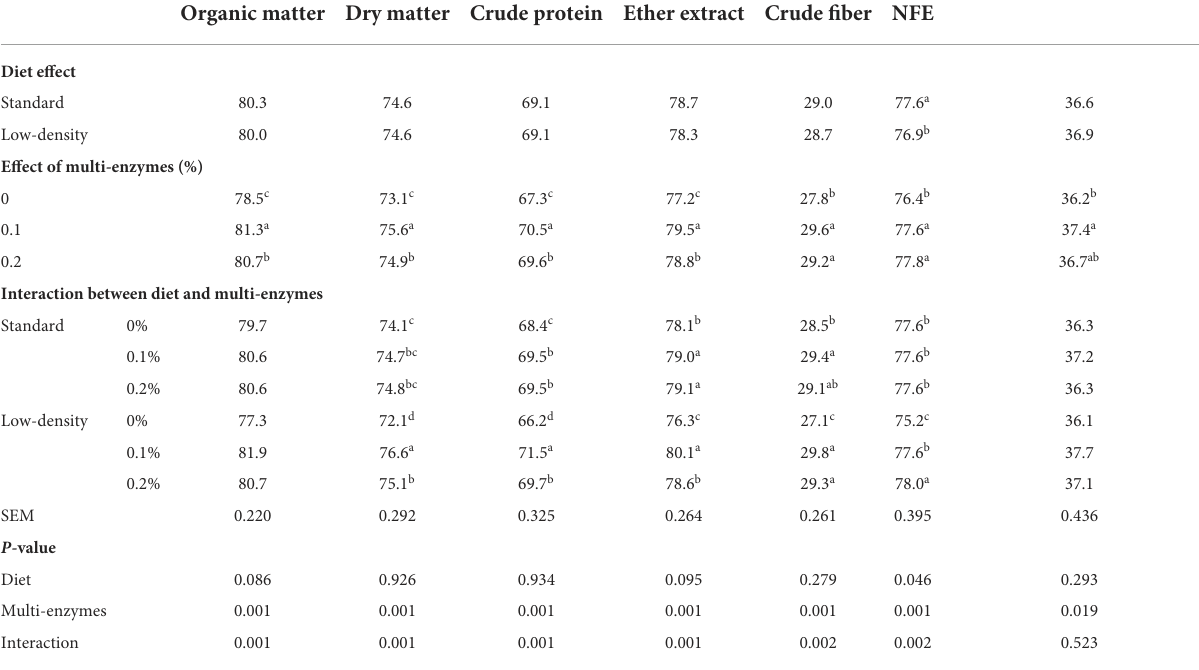
TABLE 5 Digestibility of nutrients in broilers fed standard and low-density diets supplemented with different concentrations of multi-enzymes from 1 to 38 days of age.